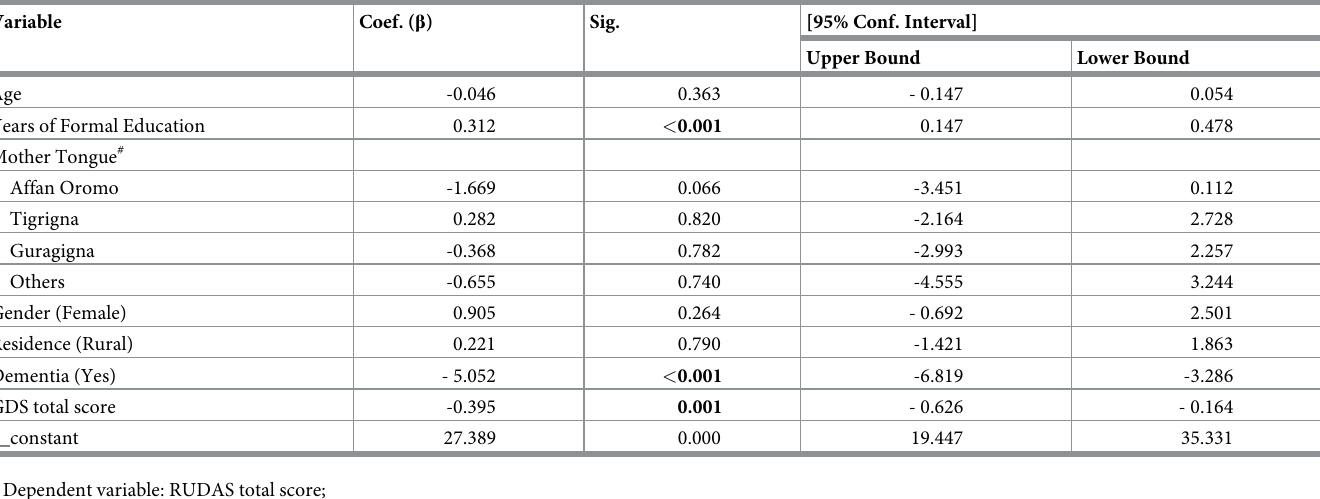
Table 3. Multiple linear regression model results for factors associated with RUDAS scores, 2020. Variable